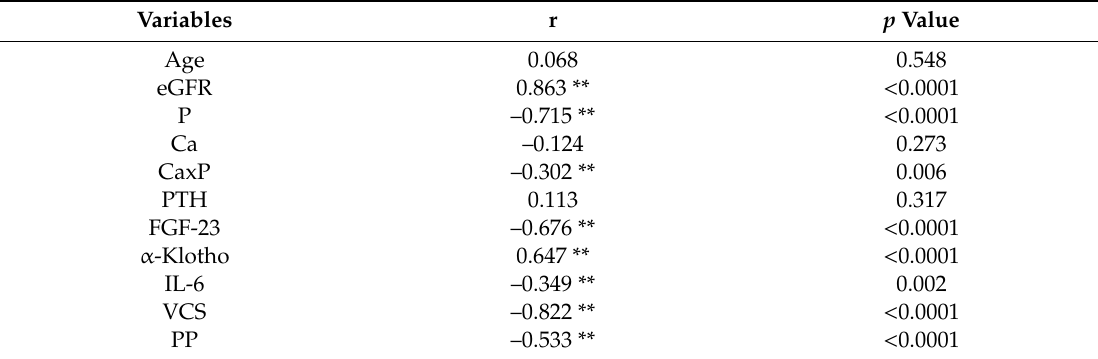
Table 2. Correlation of GRP with renal function, osteo-mineral markers and vascular calcification.